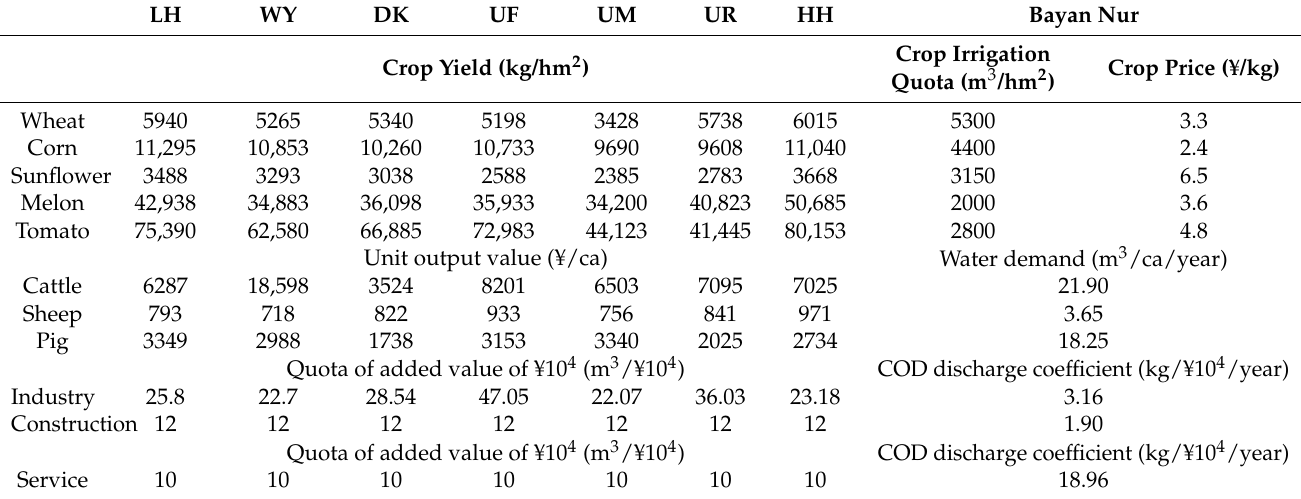
Table 1. Basic economic parameters of each industry.